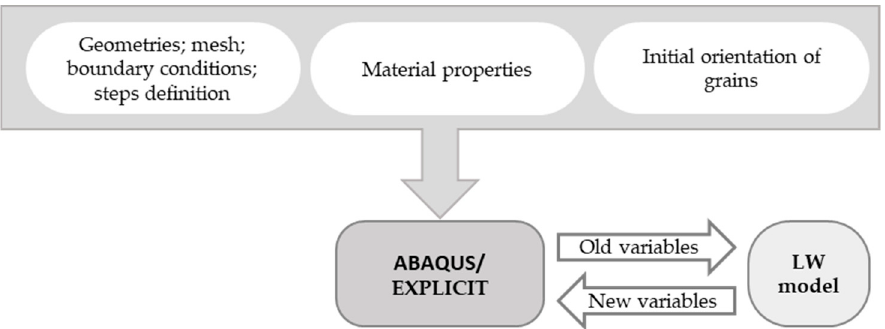
Figure 4. A schematic of the interaction between the commercial software ABAQUS and the LW model.